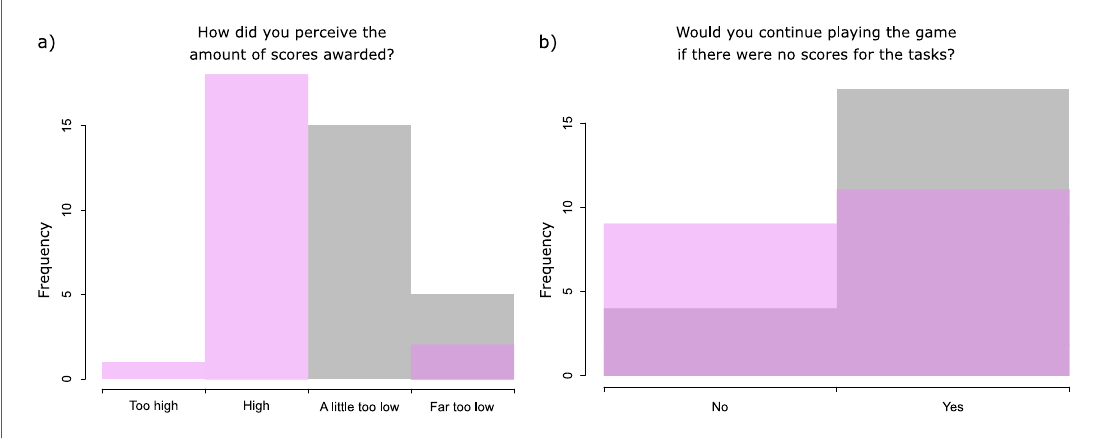
Figure 8. Histograms of responses to two questionnaire questions. ( a ) Question about the appropriateness of the scores awarded; ( b ) Question about the subjects’ willingness to play the game without any scores. The purple bars represent the response of the treatment group and the grey bars represent the control group’s response,